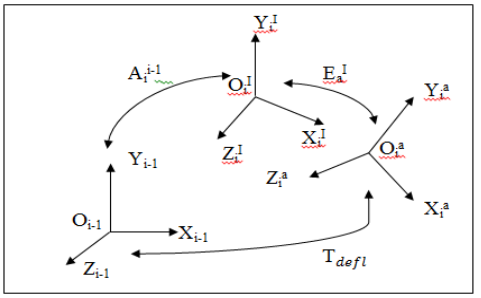
Fig. 1. Frame displacement due to errors